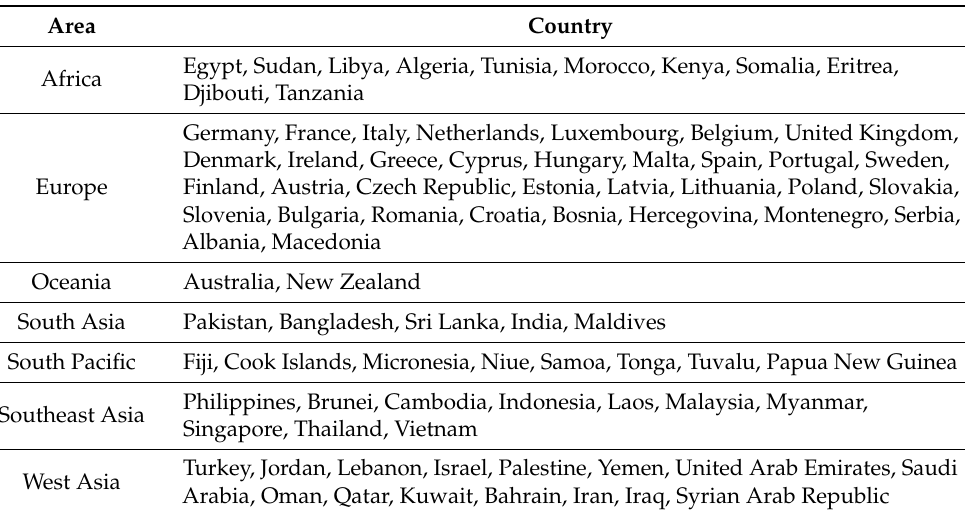
Table 1. List of countries alongside the Maritime Silk